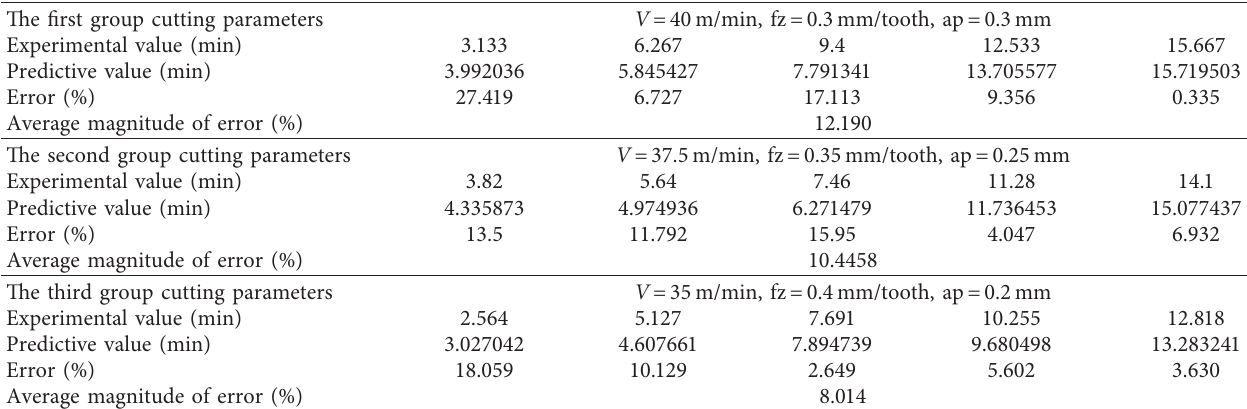
Table 7: Comparison for the experimental and predictive cutting time for each set of the cutting parameters. The first group cutting